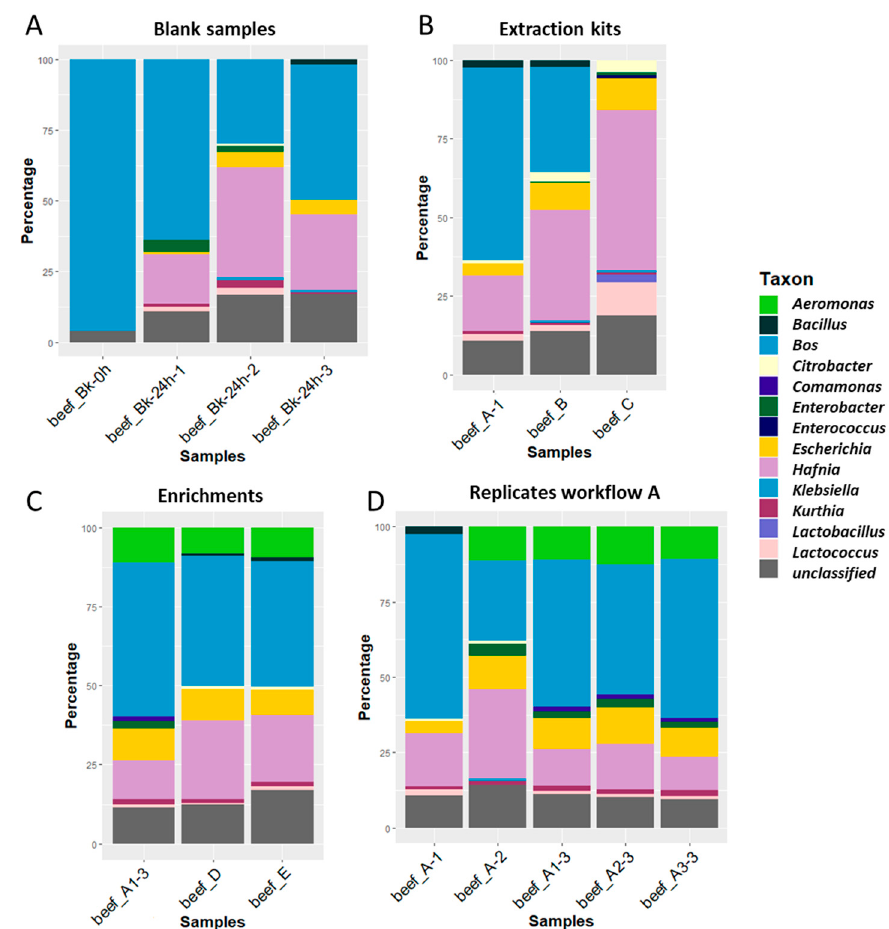
Figure 3. Percentages of reads classified to the genus level using Kraken2 (taxonomic classification tool) from beef samples with in-house databases of mammals, archaea, bacteria, fungi, human, protozoa, and viruses. Light blue represents the proportion of “ Bos ” corresponding to beef reads. Yellow represents the presence of “ Escherichia ” in the sample. The reads that could not be classified to the genus level for mammals, archaea, bacteria, fungi, human, protozoa, or viruses are represented in gray. ( A ) Blank meat samples; Bk-0h—non-enriched blank; BK-24h—non-spiked meat sample enriched for 24 h, 1–3 biological replicates. ( B ) Extraction kits; workflow A—Nucleospin Food, workflow B—DNeasy Blood & Tissue and workflow C—Zymo HostZERO. ( C ) Enrichment times; workflow A—24 h culture enrichment, workflow D—16 h culture enrichment, workflow E—16 h